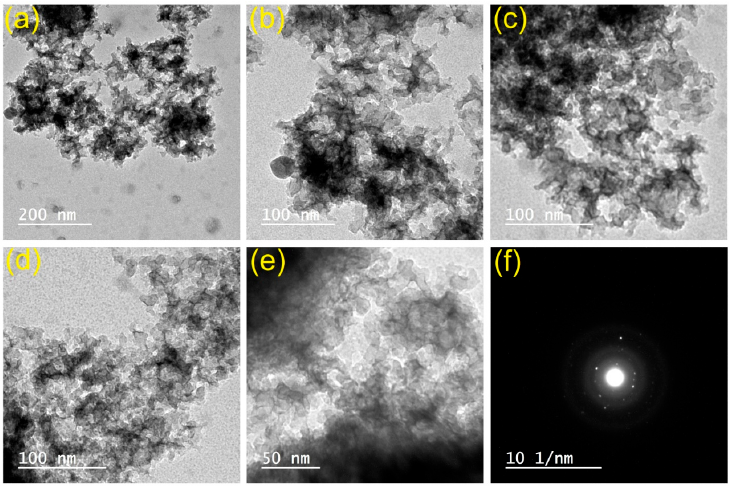
Figure 1. TEM ( a – e ) and SAED ( f ) images of